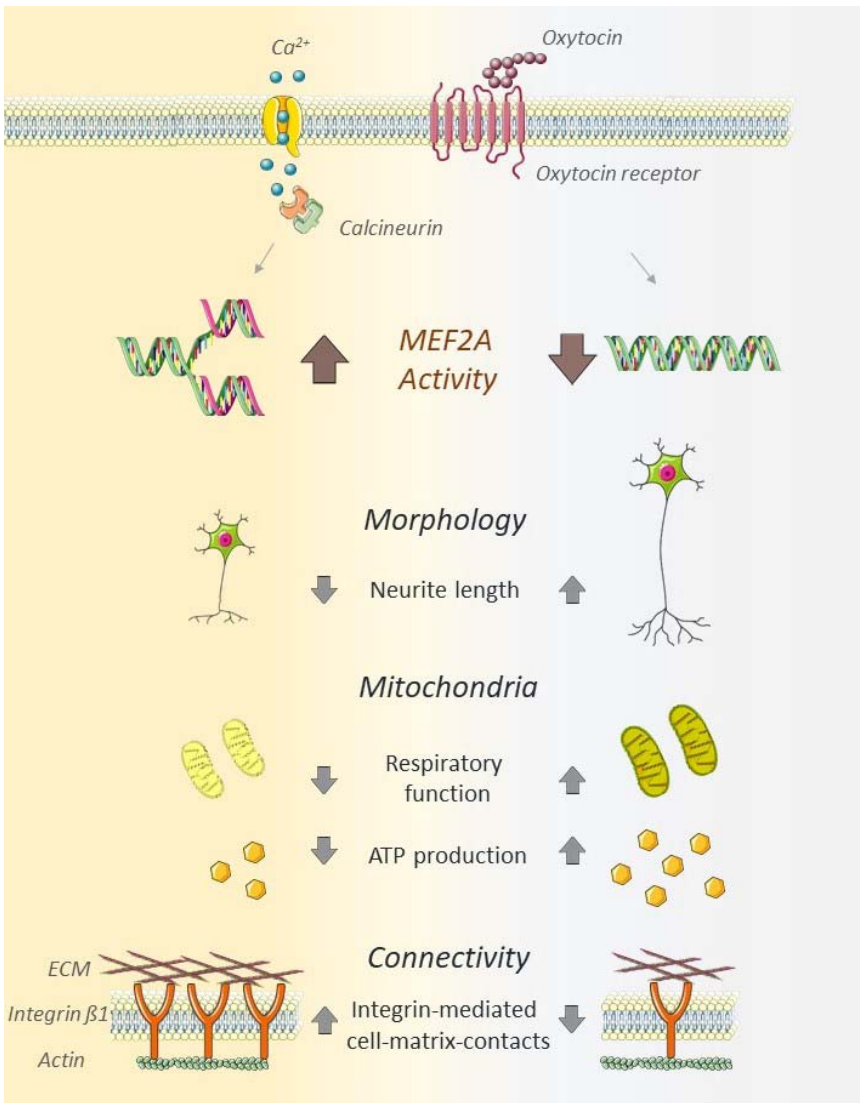
Figure 5. Schematic summary of MEF2A activity in OT-stimulated neurons. Neuronal MEF2A activity, induced by OT, reduces neurite length, decreases mitochondrial respiratory function, decreases ATP production, and increases integrin β 1-mediated cell–matrix contacts. The absence or inhibition of MEF2A induces neurite outgrowth, increased respiratory function, ATP production, and decreased cell–matrix connectivity. The schematic art pieces used in this figure were provided by Servier Medical art (http://servier.com/Powerpoint ‐ image ‐ bank). Servier Medical Art by Servier is licensed under